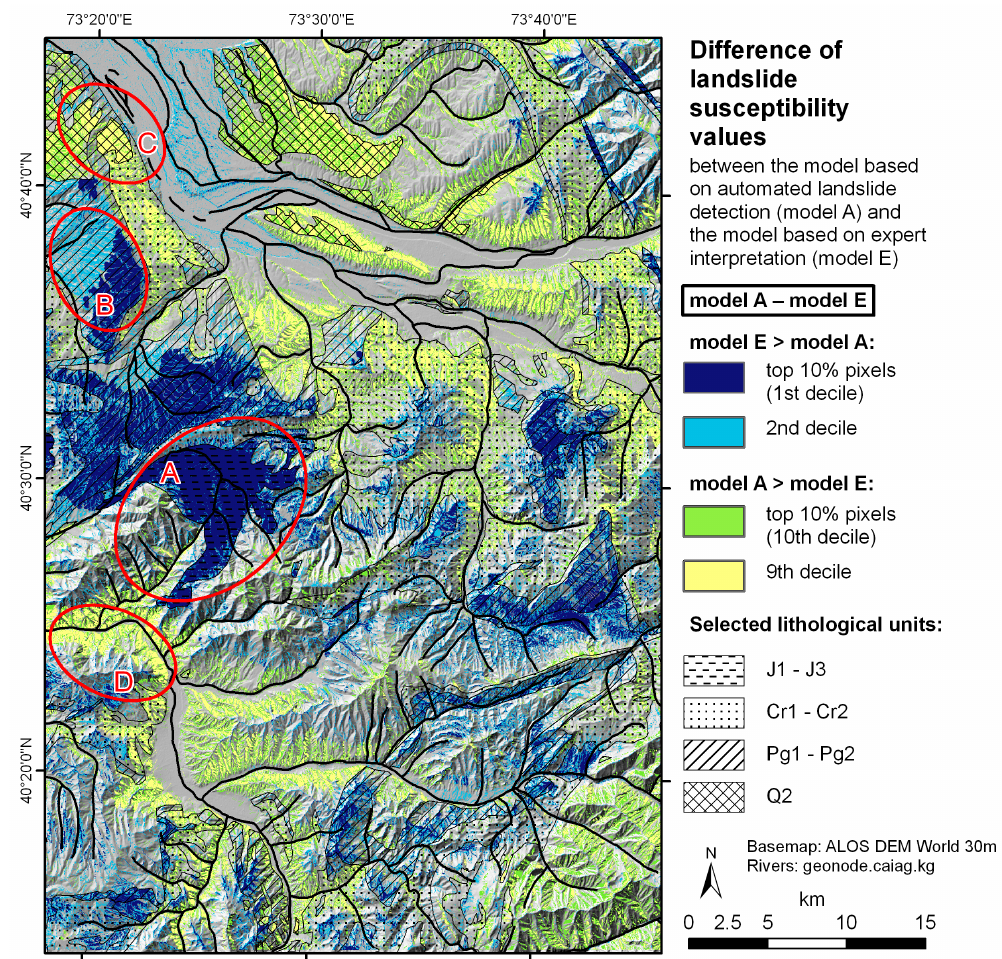
Figure 5. Difference between susceptibility maps produced using the results of automated detection (landslide masses, “model A”) and expert interpretation (“model